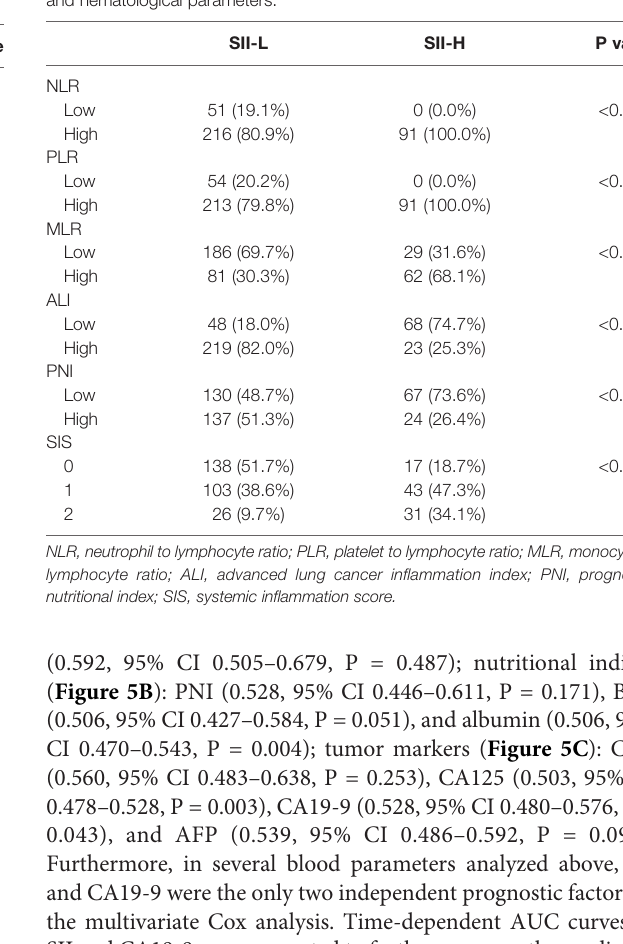
TABLE 3 | Association between the systemic immune – in fl ammation index (SII) and hematological